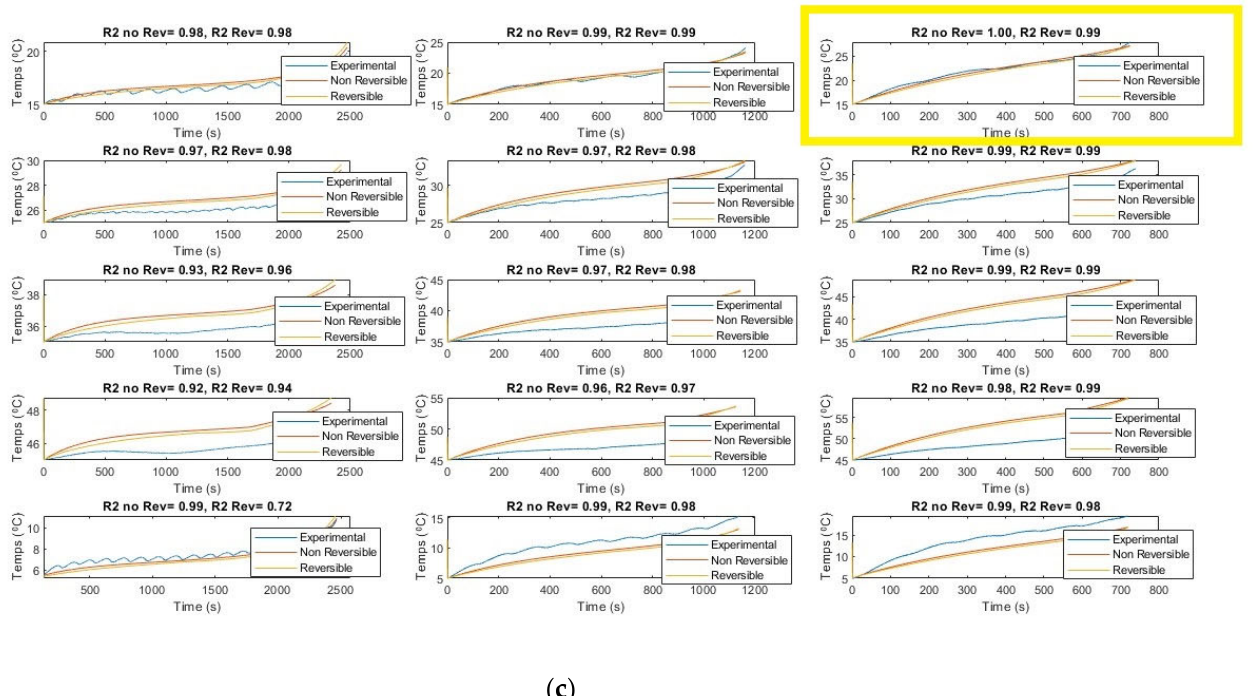
Figure 5. ( a – c ) Reversible and simple Rint heat models for battery at stated SOH at 5 different ambient temperatures and 3 stated C rates. ( a ) Simulated temperatures at ambient temperatures shown and with C rates of 1C, 2C, 3C from left to right with an SOH of 90%. (Highest Accuracy Reversible Model highlighted see Table 6 for details). ( b ) Simulated temperatures at ambient temperatures shown and with C rates of 1C, 2C, 3C from left to right with an SOH of 83% (Highest Accuracy Model highlighted). ( c ) Simulated temperatures at ambient temperatures shown and with C rates of 1C, 2C, 3C from left to right with an SOH of 65%. (Highest Accuracy Non-Reversible Model highlighted see Table 6 for details). Table 6. Pearson Values for 0D thermal models with and without Reversible Heat Term. (Highest Accuracy Highlighted).